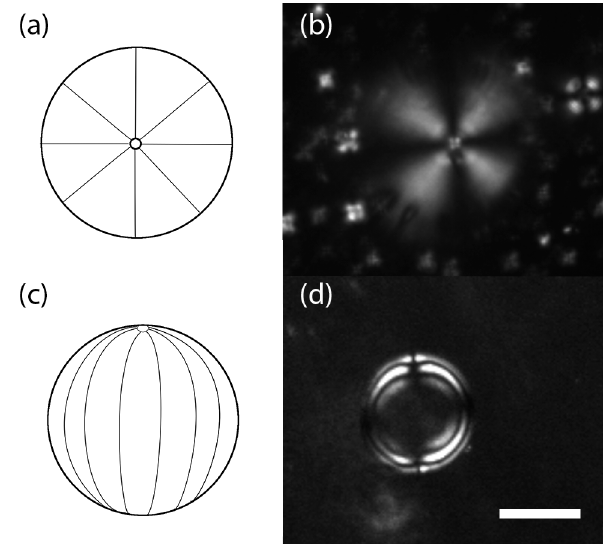
Figure 1. Two common director configurations for a nematic liquid crystal droplet. Radial (single defect in the center): ( a ) schematic, and ( b ) crossed polarizer image of a droplet suspended in aqueous solution, and bipolar (two surface defects), ( c ) schematic, and ( d ) crossed polarizer image of a droplet suspended in aqueous solution. Scale bar = 20 μ m.